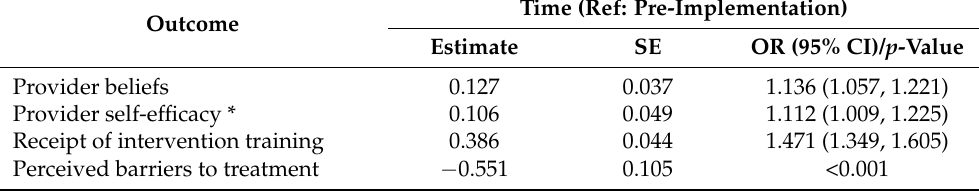
Table 3. The Effect of Comprehensive Tobacco-Free Workplace Program Implementation on Provider Beliefs, Provider Self-Efficacy, Receipt of Intervention Training, and Perceived Barriers to Treatment (N = 15 SUTCs).